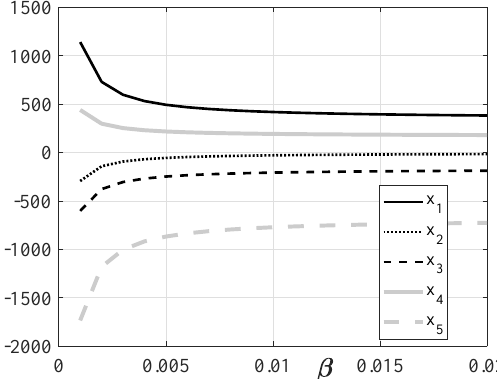
Figure 3. Evolutions of the five components of the point P 3